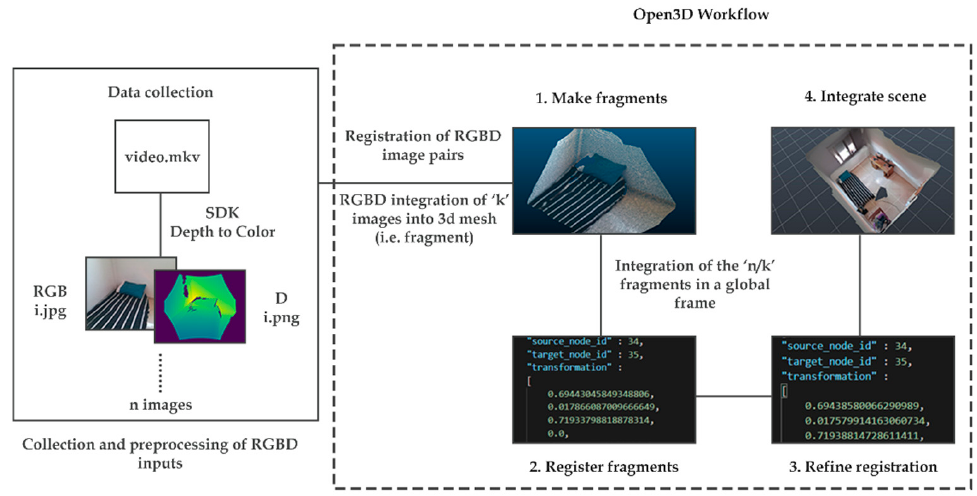
Figure 6. Diagram of the reconstruction of a 3D point clouds from RGB-D data on Open3D.